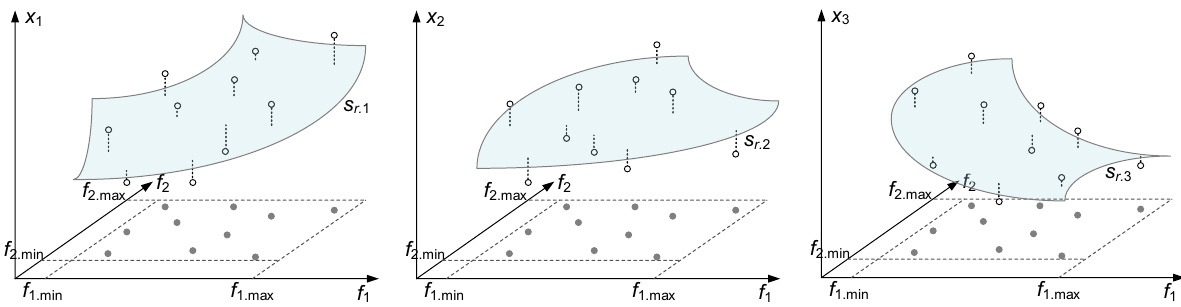
Figure 1. Visualization of the regression surrogate s r constructed using the accepted observables x r ( j ) and their respective objective vectors f r ( j ) : each component of s r . j , corresponding to a consecutive antenna parameter x 1 (left), x 2 (middle), and x 3 (right), is shown as the grey-shaded manifold; black circles mark the observables, whereas black squares are their counterparts in the objective